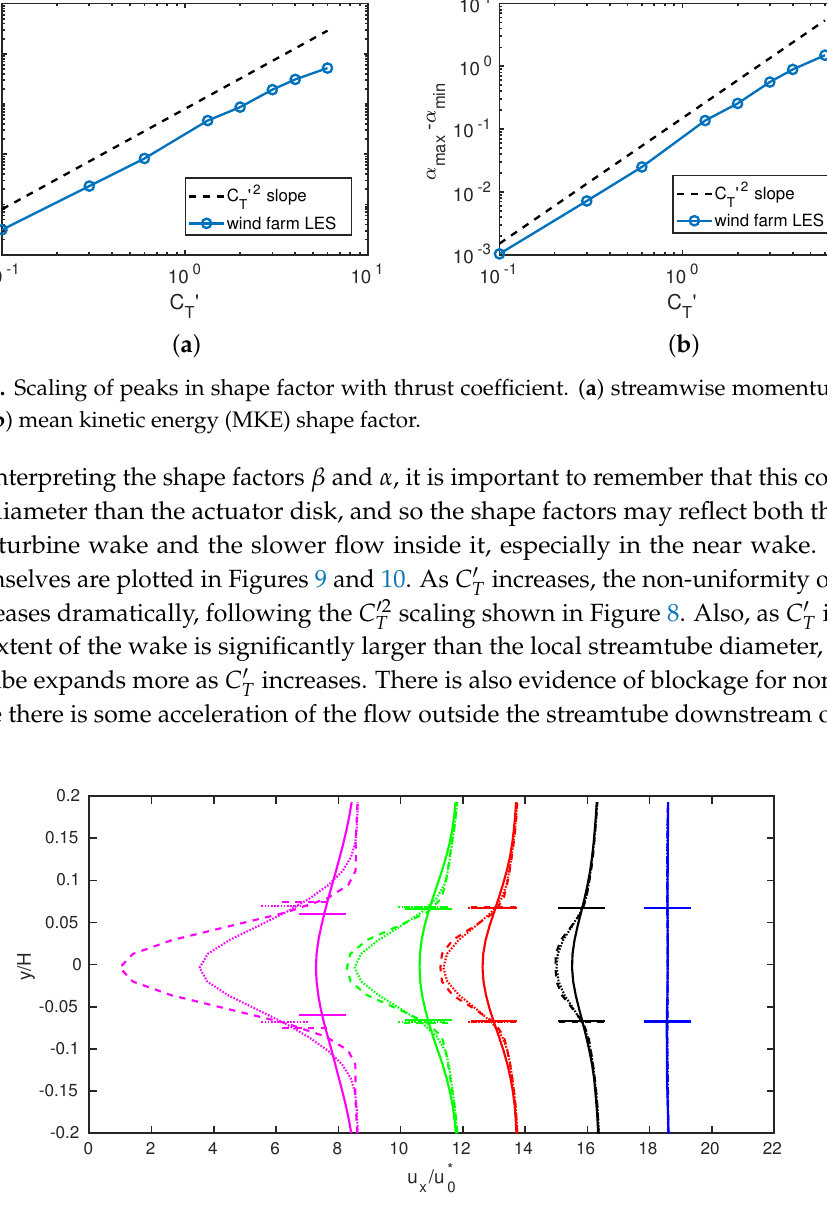
Figure 9. Streamwise velocity profiles in the horizontal plane at hub height. In each group, solid lines = 1 diameter upstream of turbine, dashed = 1 D downstream, dotted = 2 D downstream. = [ 3.0, 0.6, 0.3, 0.1, 0.0 ] . Some cases are omitted for the The groups, in order from left to right, have C (cid:48) T sake of clarity. Horizontal lines indicate the width of the streamtube at different downstream